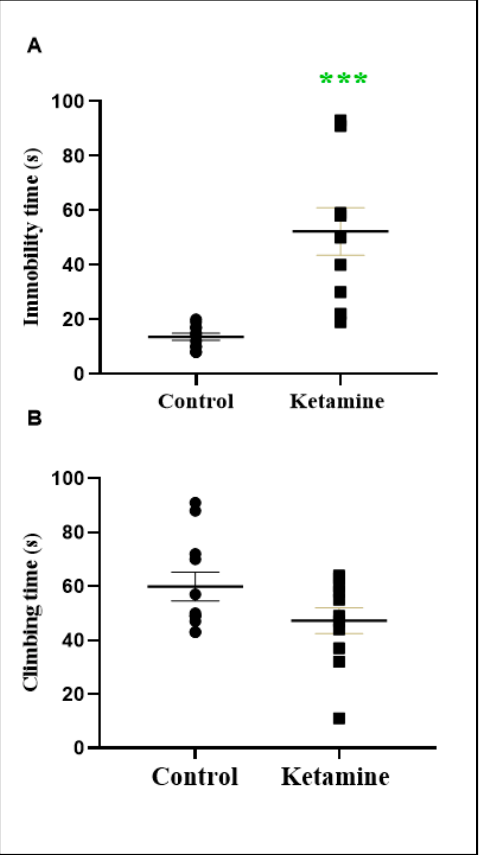
Figure 4. Effects of ketamine recreational regimen (10 mg/kg/day for 3 days, i.p) or saline (control group) in the early withdrawal (24 h) stage on depressive-like parameters in forced swim test of adolescent female Wistar rats ( n = 10 animals/group). Panel ( A ) represents the immobility time (seconds); Panel ( B ) represents the climbing time (seconds). Results were expressed as mean ± S.E.M. *** p < 0.001 compared to control group. Student t-test.